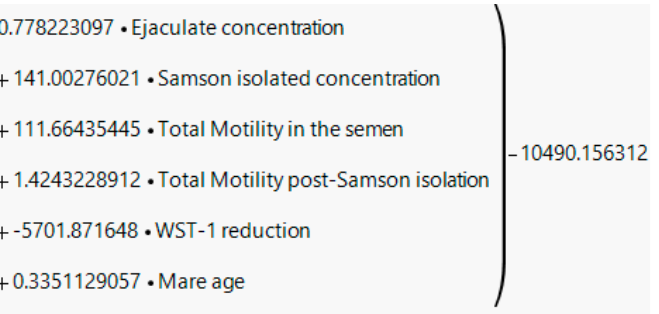
Figure A3. Equation optimized for stallion 2 from the pre-chilled data set: predictive accuracy of 100%.